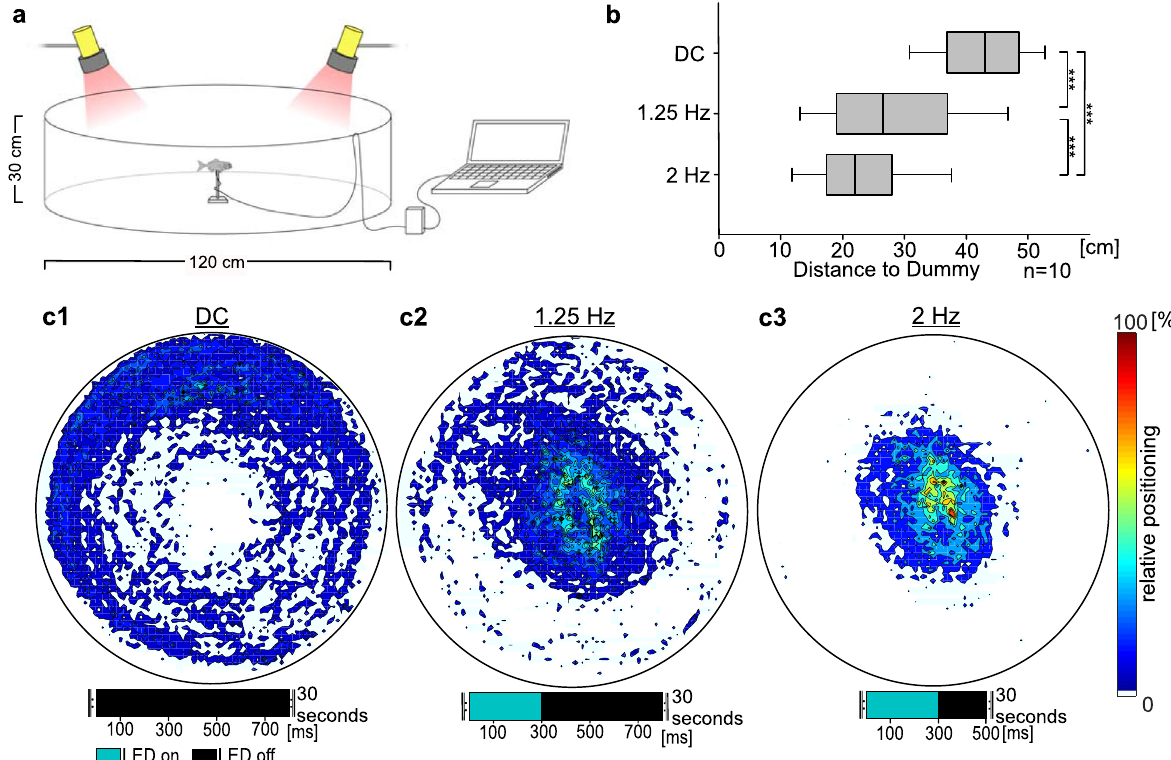
Figure 2. Frequency-dependent light stimuli transmitted by artificial light organs determine nearest neighbor distance of A. katoptron . ( a ) Experimental setup for the validation of changes in nearest neighbor distance. Artificial light organs of a center placed dummy were emitting different light stimulations. ( b ) Average distance between A. katoptron and the fish dummy equipped with artificial light organs (n = 10). ( c ) Heat Maps indicate positioning of A. katoptron in relation to no light ( c1 ) or light ( c2 , c3 ) emitting dummy. Heat Maps are based on all trajectories recorded for each stimulation (n = 10). Figures were created with SigmaPlot 12.0 (www. sigma plot. co. uk) and processed with CorelDraw Graphics Suite 2017 (www. corel draw. com). DC, dark control. Significance values are reported as: * p < 0.05, ** p < 0.01, *** p <